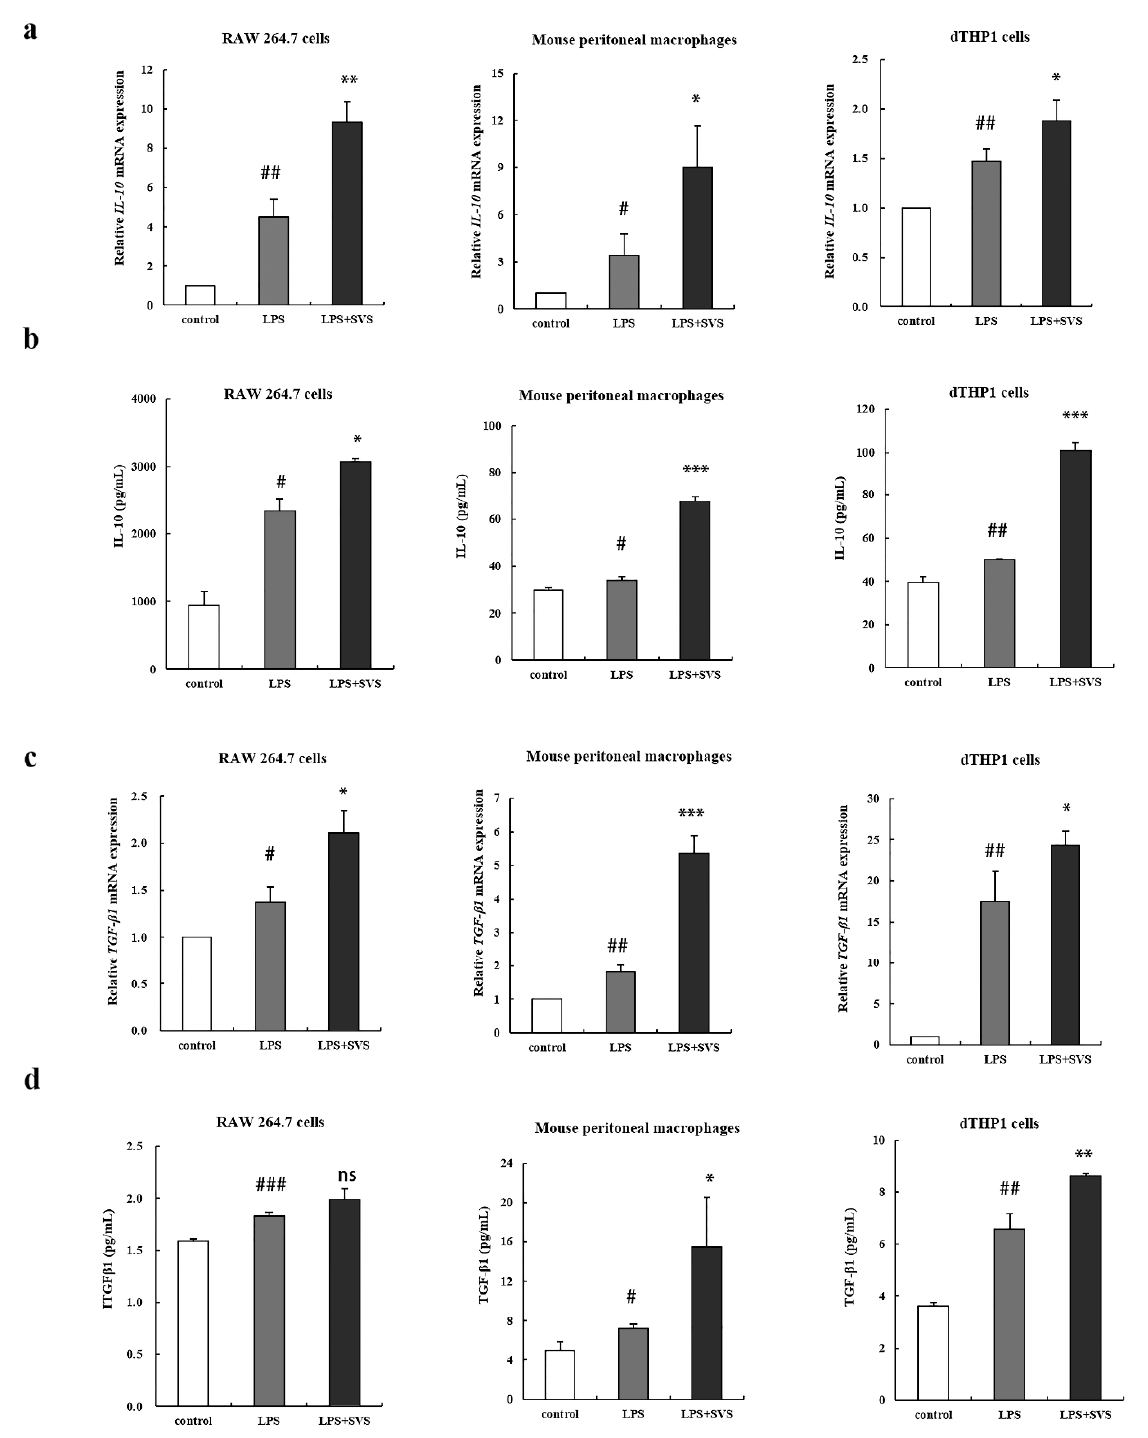
Figure 3. Stevioside enhanced IL-10 and TGF- β 1 expression in LPS-stimulated macrophages. Macrophages were pretreated with or without stevioside (100 μ g/mL) for 1 h and then stimulated with LPS (1 μ g/mL) for another 9 h ( a , c ) or 24 h ( b , d ); ( a , c ) mRNA levels of IL-10 ( a ) and TGF- β 1 ( c ) in the cells was detected by RT-qPCR; ( b , d ) Protein levels of TNF- α ( b ) and IL-1 β ( d ) were detected by ELISA in the supernatant of macrophages. Experiments were repeated three times. # p < 0.05, ## p < 0.01, ### p < 0.001 versus control group; * p < 0.05, ** p < 0.01, *** p < 0.001 versus LPS-treated group. ns, no significant difference versus LPS-treated group. SVS, stevioside.